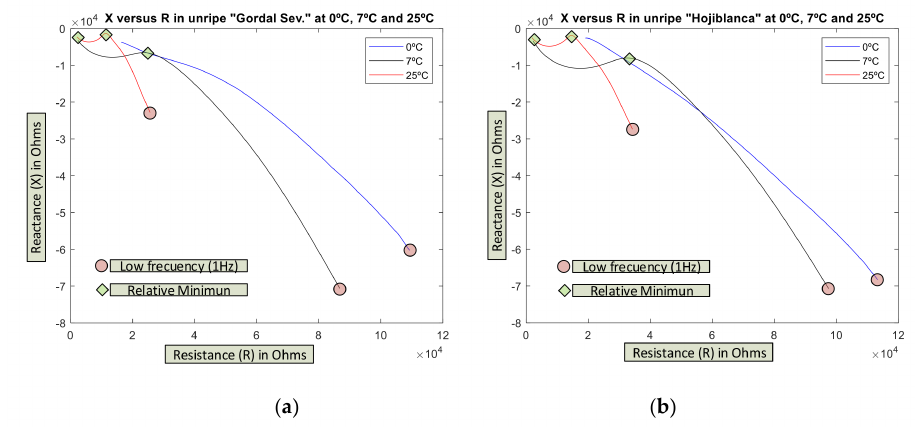
Figure 5. Evolution of the impedance in ( a ) unripe “Gordal Sevillana” and ( b ) “Hojiblanca” varieties at 3 temperatures: 0 ◦ C, 7 ◦ C, and 25 ◦ C (average of 100 tests). The red circles corresponds to f = 1 Hz.